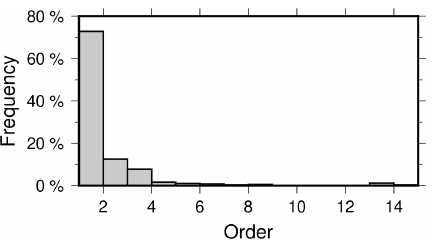
Figure A1. Histogram of the optimal order of an AR model for global detrended and deseasoned GRACE-TWSC on land